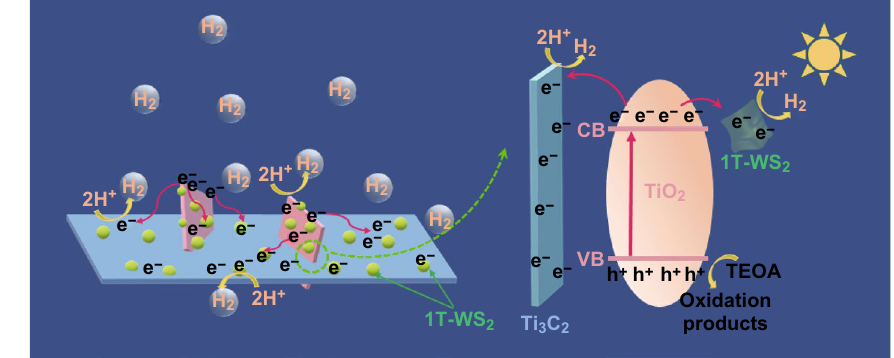
Scheme 2 Schematic photocatalytic mechanism of 1T-WS 2 @TiO 2 @Ti 3 C 2